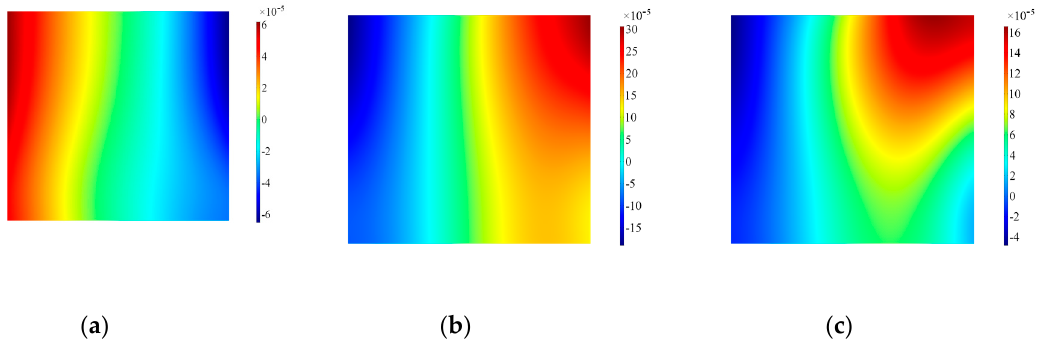
Figure 14. Surface plot for the out-of-plane velocity on the side of the backing mass, Configuration A. Note that data are plotted at timeframes of 100 μ s ( a ), 300 μ s ( b ) and 500 μ s ( c ).